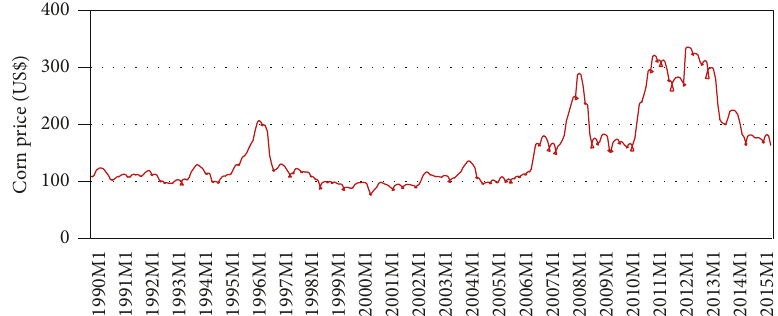
Figure 3: Time plot for corn price (unit: US dollars per metric ton). Table 11: Parameter estimates for corn prices. The ARIMA